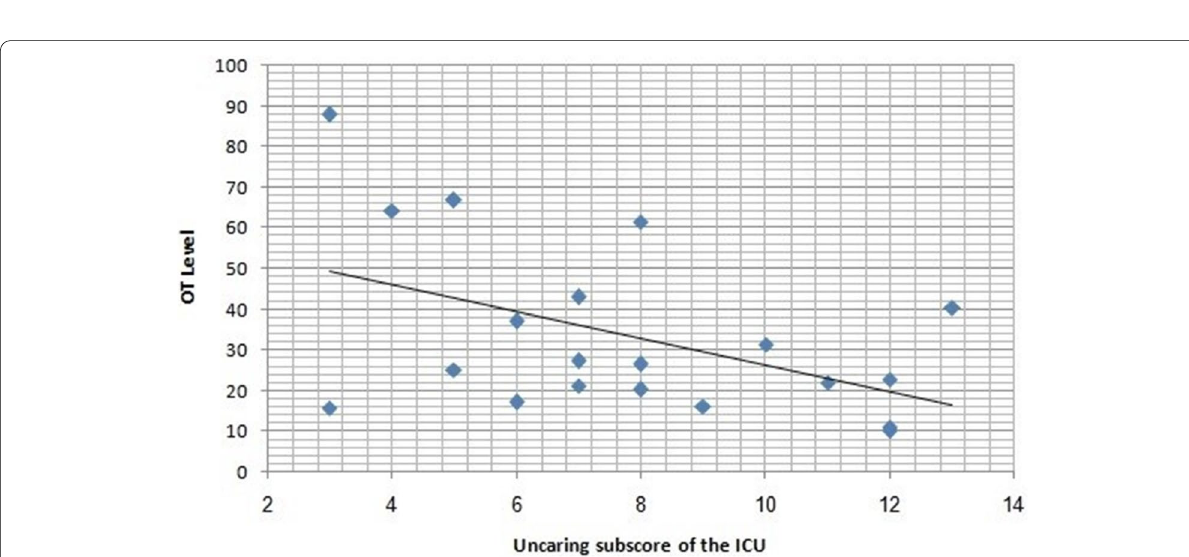
Fig. 4 Correlation between oxytocin levels and the uncaring subscore of the Inventory of Callous-Unemotional Traits (ICU—self -